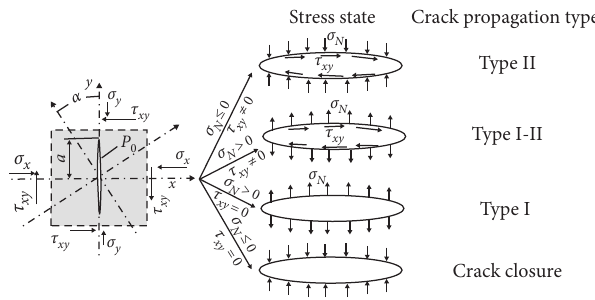
Figure 3: Crack stress state and crack propagation